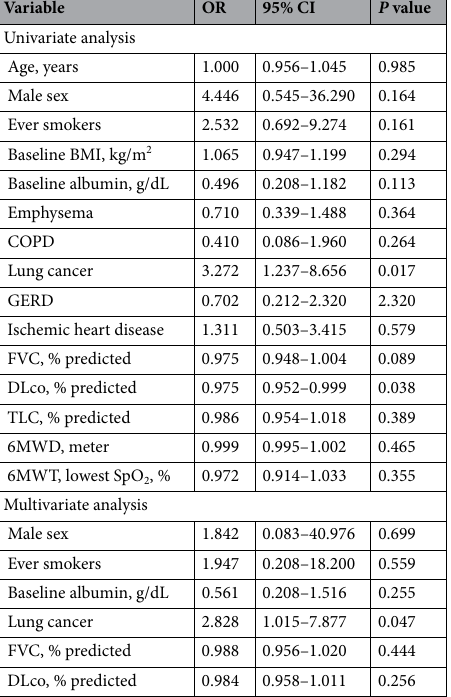
Table 3. Logistic regression analysis of risk factors for weight loss. BMI body mass index, COPD chronic pulmonary obstructive disease, GERD gastroesophageal reflux disease, FVC forced vital capacity,